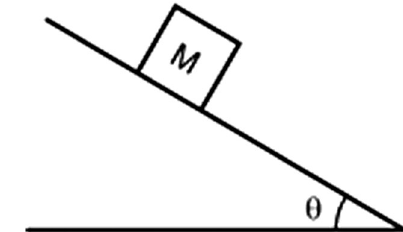
FIG. 10. Figure for friction post-test problem 7.